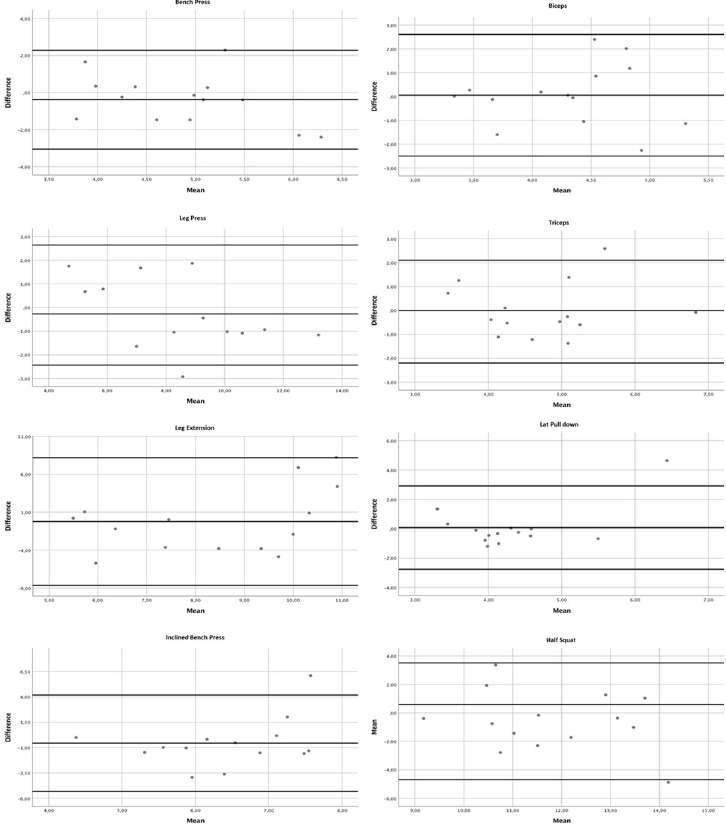
Fig 2. Bland–Altman plots showing the difference between measured and predicted energy cost against the mean of differences in the eight resistance exercises.